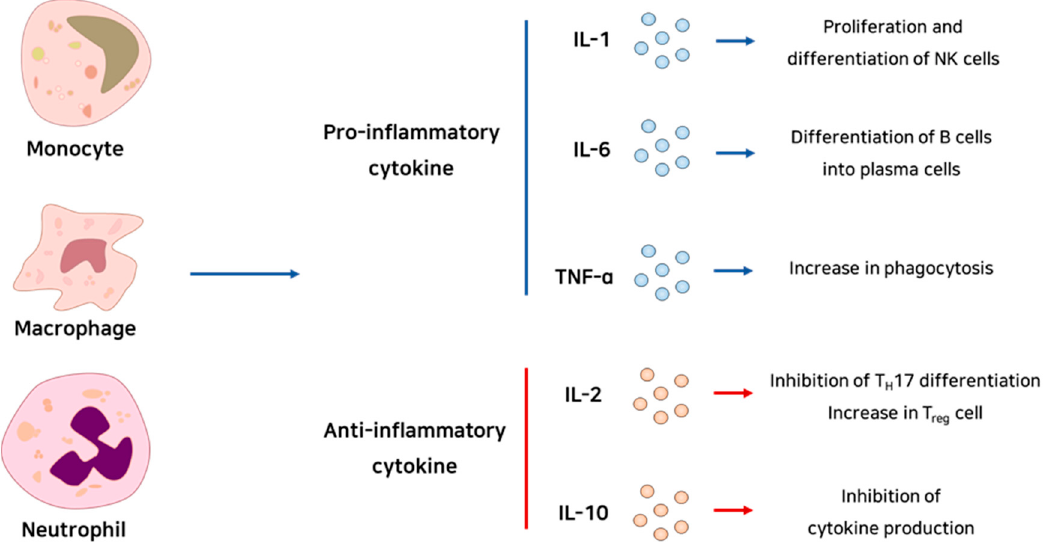
Figure 1. Schematic summary of immunoregulatory cells and cytokines.